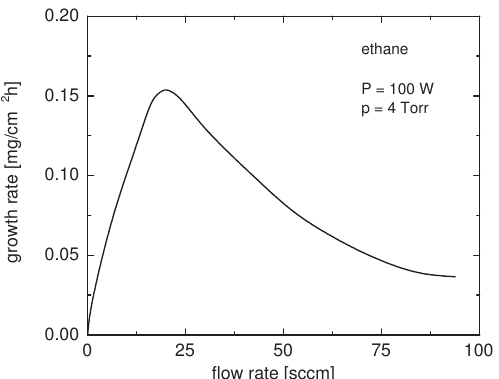
Figure 5. Schematic diagram of the growth rate of a polymer which is deposited when ethane is subjected to an RF discharge after Jensen et al. Shown the growth rate (weight gain per hour) as function of the flow rate of ethane at constant plasma conditions